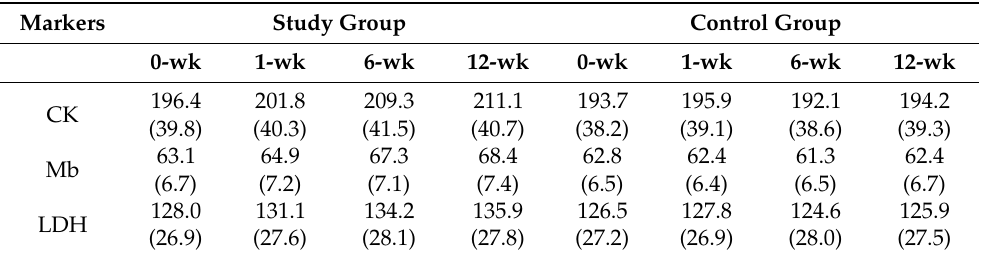
Table 3. Serum markers of muscle damage at different time points during the intervention programme based on resistance training in young adults with Down syndrome. Markers Study